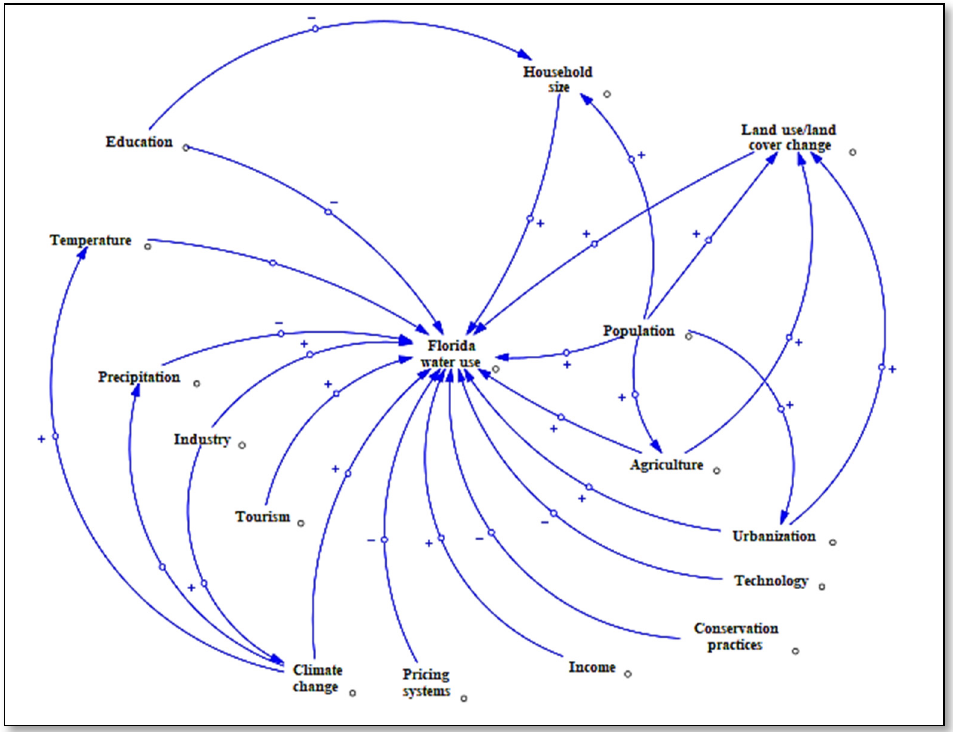
Figure 12. Causal loop diagram showing interrelationships between water use and its drivers in Florida. The drivers are represented as texts. Causal relationships are defined as arrows with plus (+) and minus (-) symbols showing the direction of causality (Positive signs increase, and negative signs reduce). Table 1. Sources of publications for water use driver identification.